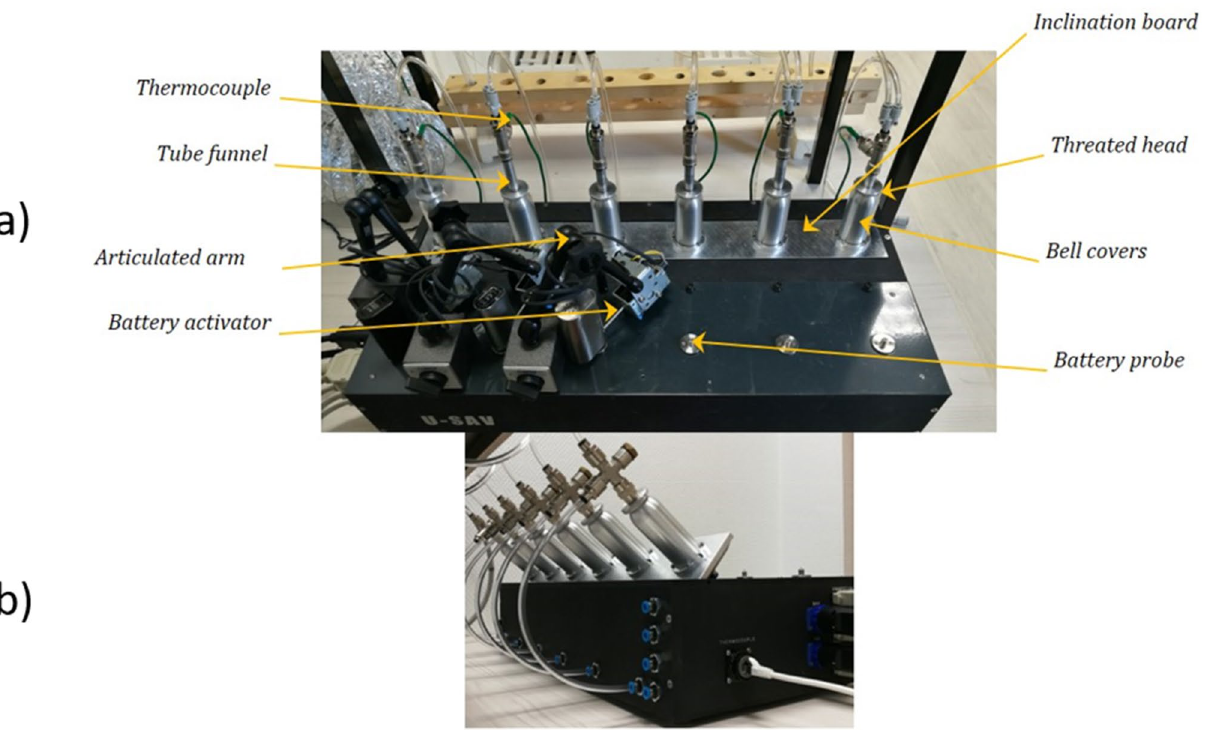
Figure 1. The universal system for analysis of vaping (U-SAV) machine. ( a ) The U-SAV machine allows the user to plug in a wide range of commercially available atomizers and batteries. ( b ) The atomizers can be tilted from 0° to